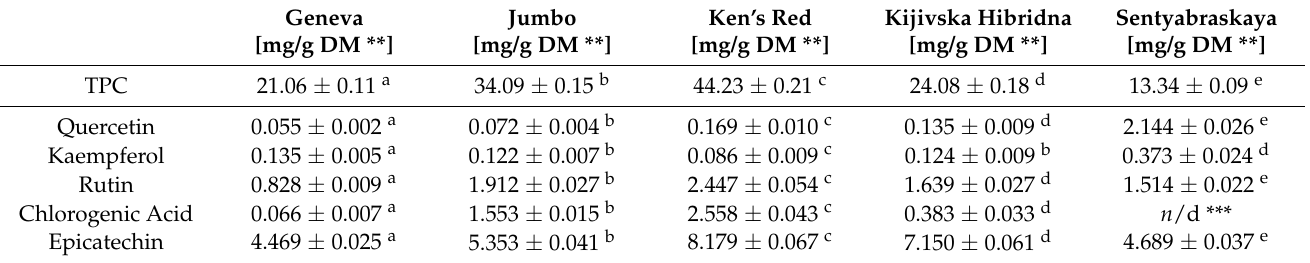
Table 1. Quantitative analysis of the content of active compounds in the tested Actinidia varieties.